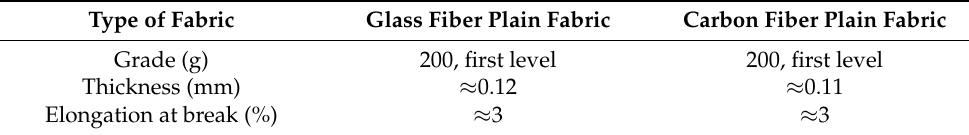
Table 3. Physical properties of the glass fiber fabric and carbon fiber